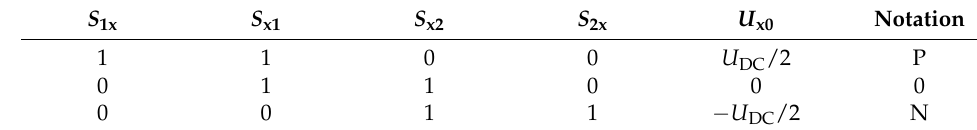
Figure 1. Schematic of a three-level DC–AC converter. Table 1. Switching states of a three-level DC–AC converter.